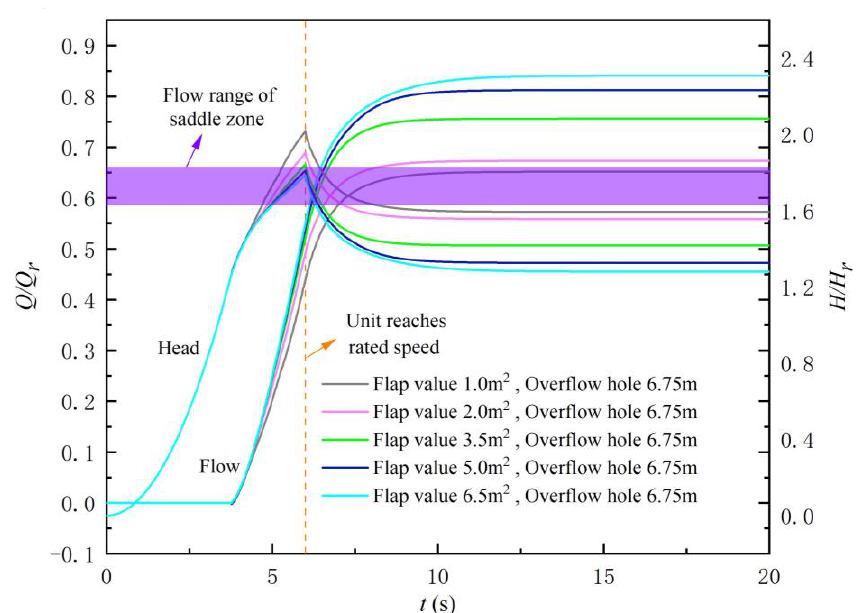
Figure 20. Variation patterns of the flow and head of the LAPS equipped with FLVA and restricted OVHO under gate refusal working conditions.